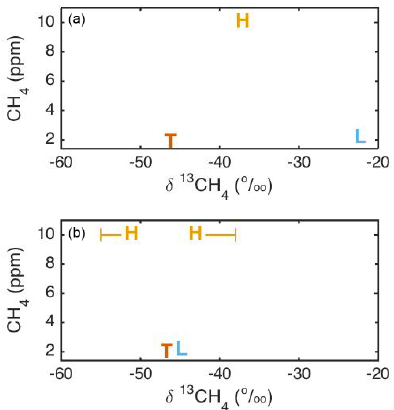
Figure 18. Graphical representation of the field tanks used in the present study (a) , and for an improved strategy (as in Table 4; b ). Orange “H” symbols indicate high mole fraction tanks, blue “L” symbols indicate low mole fraction tanks, and red “T” symbols in- dicate target tanks. Lines in (b) indicate range of isotopic values desirable for the high